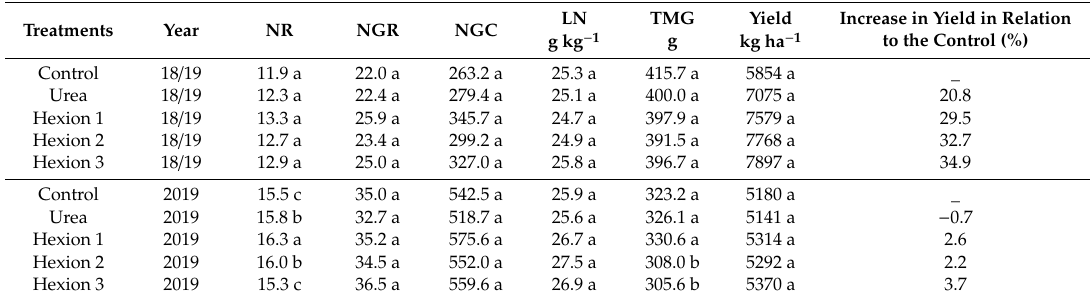
Table 3. Average data of number of rows (NR), number of grains per row (NGR), number of grains per cob (NGC), leaf nitrogen (LN), thousand mass grain (TMG), and yield, as a function of treatments